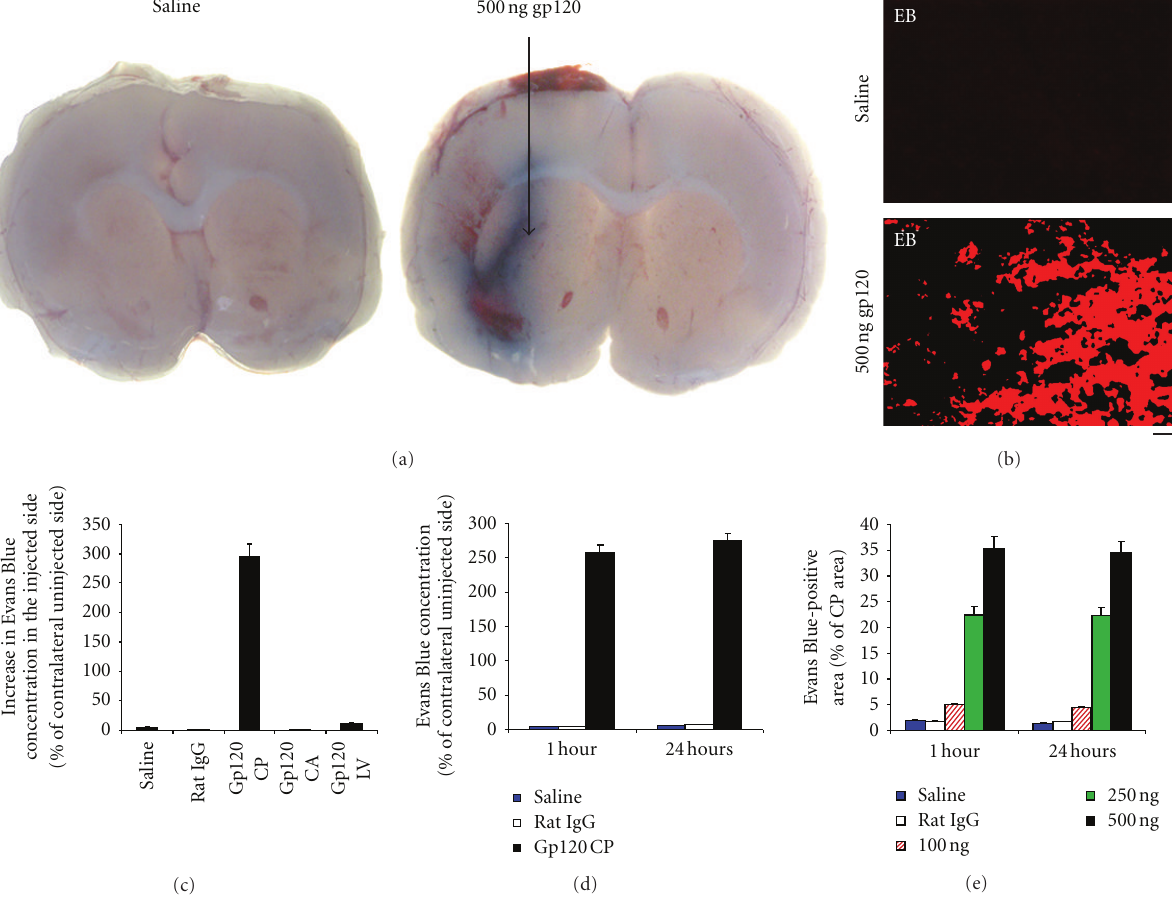
Figure 1: Injection of gp120 into the rat caudate-putamen (CP) induced extravasation of Evans Blue (EB). (a) EB was injected intravenously before injection of gp120. Gp120 (500ng in 1 μ l saline) was injected stereotaxically into the rat CP using coordinates obtained from the rat brain atlas of Paxinos and Watson (1986). Controls received saline or rat IgG. One day later, extravasation of EB was seen in the CP. (b) Fluorescence corresponding to EB extravasation was observed by microscopy in the injected CP. (c) Spectrophotometric measurements representing the specific absorbance of EB at 620 nm showed that EB levels were higher in the CP injected with gp120 compared to CPs injected with saline or rat IgG. Furthermore, injection of gp120 into the carotid artery (CA, 2000 ng gp120) or the lateral ventricle (LV, 2000 ng gp120) did not increase EB levels in the CP. (d) EB levels in the CP were almost similar 1 hour and 1 day after gp120 injection. (e) Relationship between the concentrations of gp120 and the levels of EB. Bar: (b) 100 μ